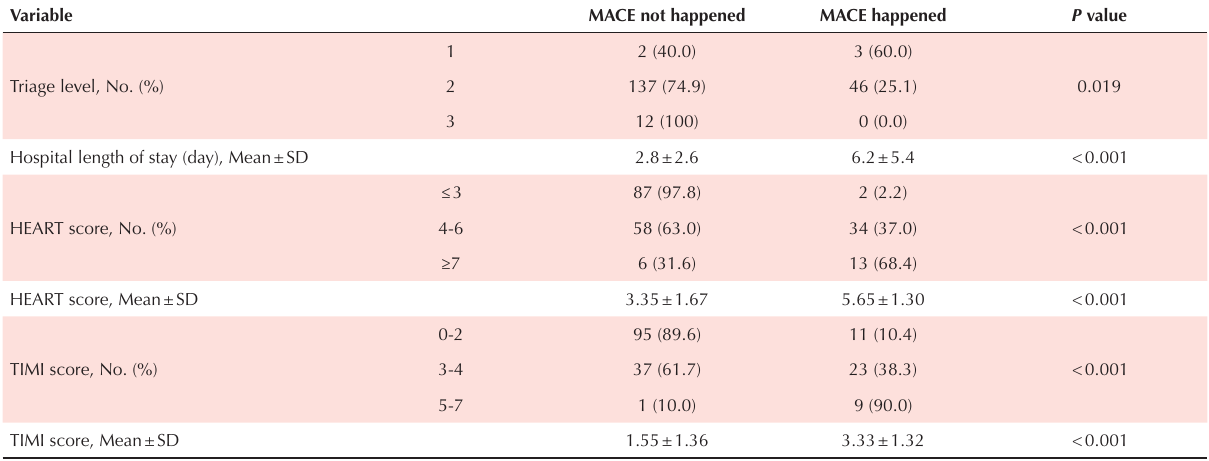
Table 2. Relationship of study variables with MACE